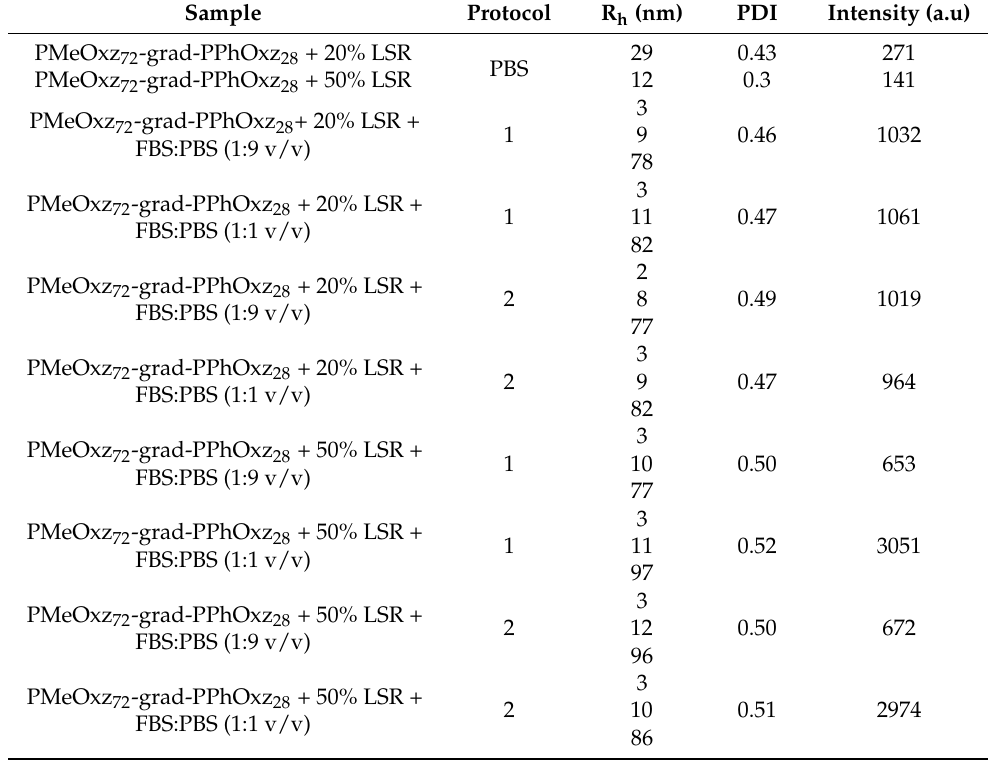
Table 4. Physicochemical characteristics of LSR-loaded PMeOxz 72 -grad-PPhOxz 28 nanocarriers and protein-GC/drug mixtures obtained from DLS measurements based on the protocol used for their preparation. Data for R h denote multiple